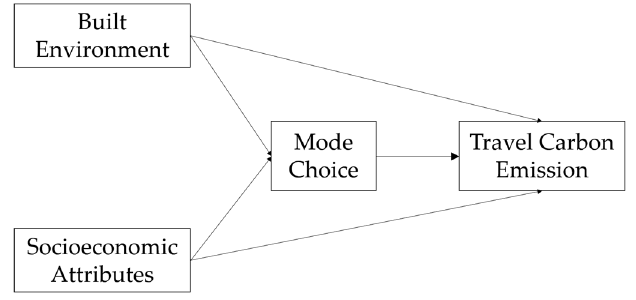
Figure 6. Theoretical framework of SEM.